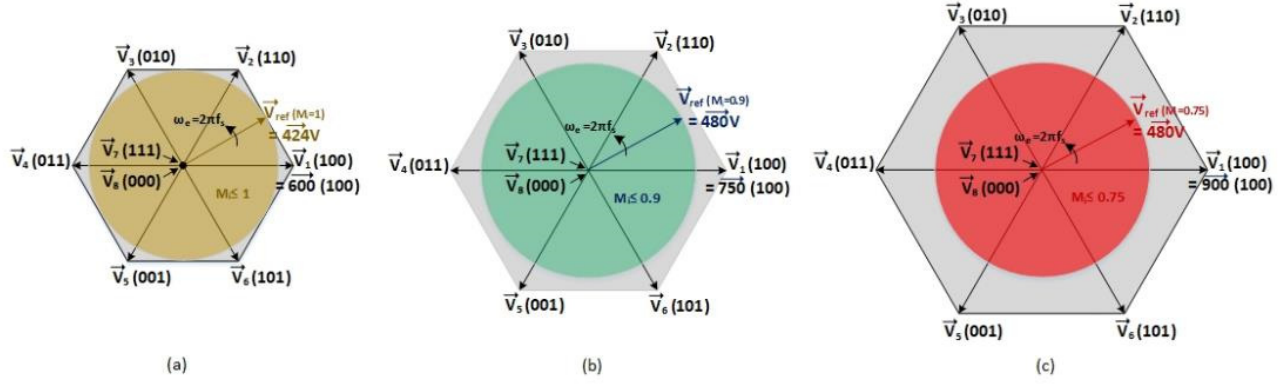
Figure 6. Hexagons containing colored discs represent variable speed operating regions bounded by ( a ) V dc (min) = 600 V (M i = 1 can give only 424 V l-to-l), ( b ) V dc (rated) = 750 V (M i = 0.9 to give